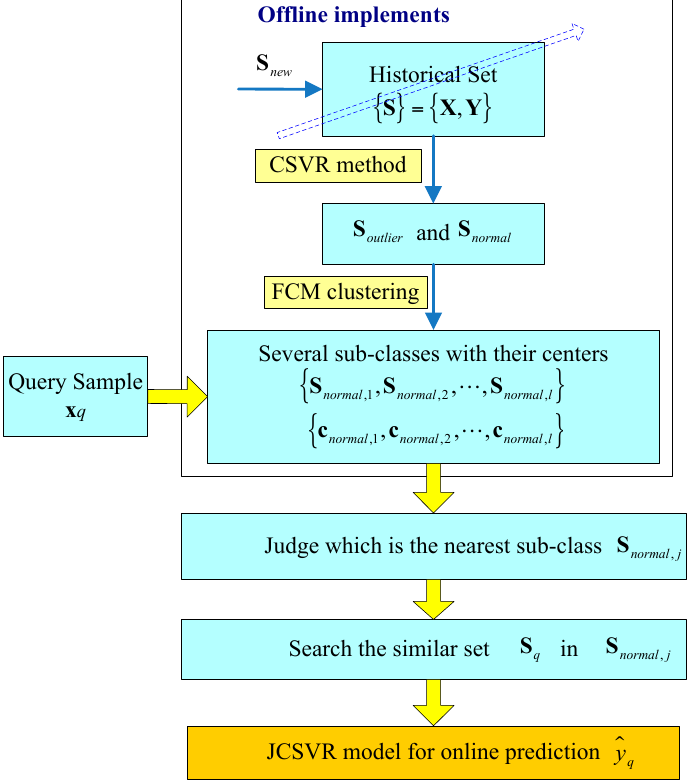
Figure 1. Main implemented steps of the proposed soft sensor modeling method integrating both of offline implements and online JCSVR method.